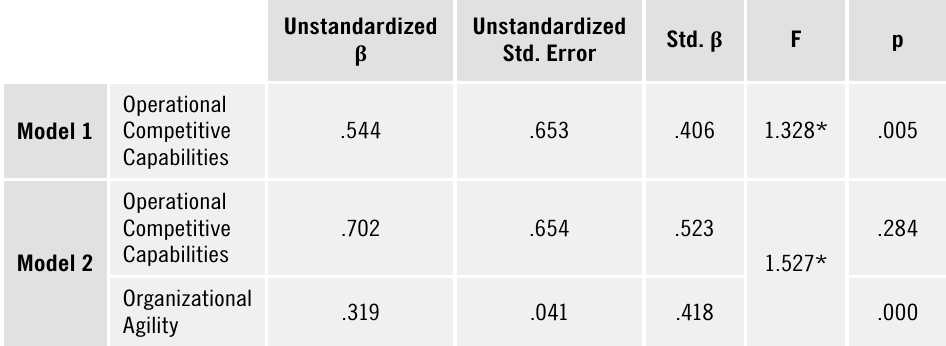
Table 7. Mediating variable